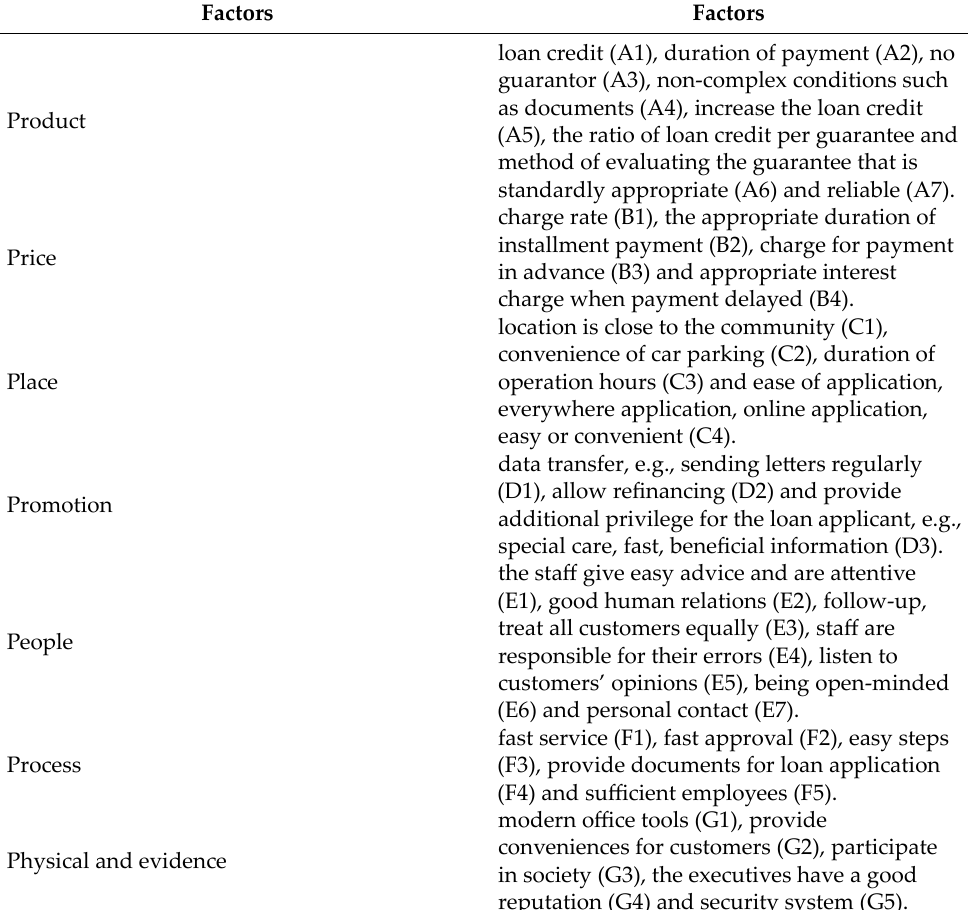
Table 9. Preference factors for hybrid decision